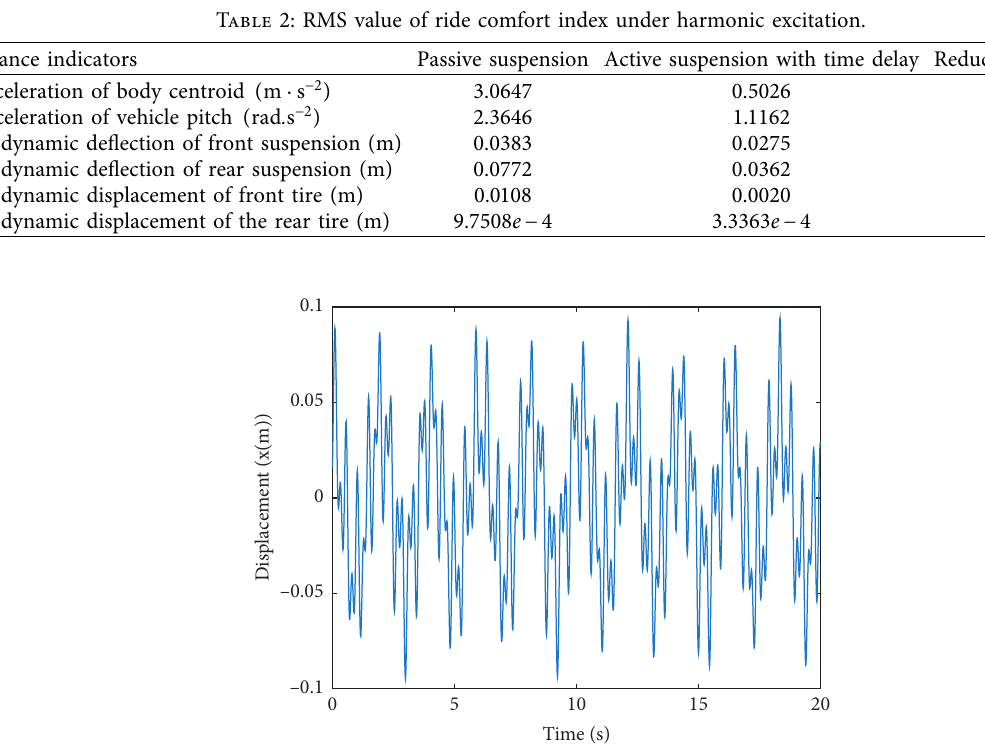
Figure 6: Disturbance change curve of random excitation displacement.